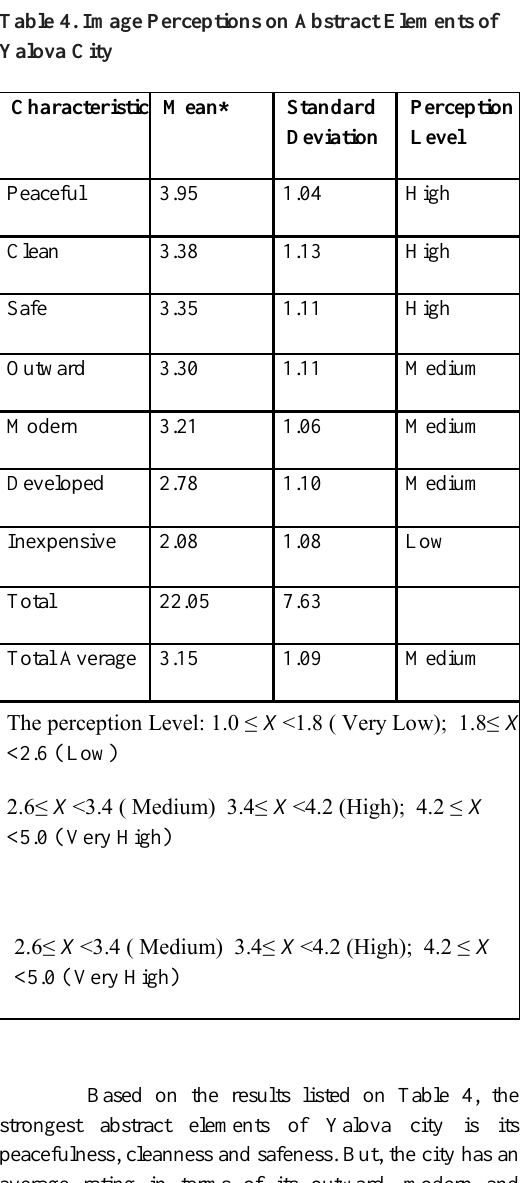
Table 4. Image Perceptions on Abstract Elements of Yalova City